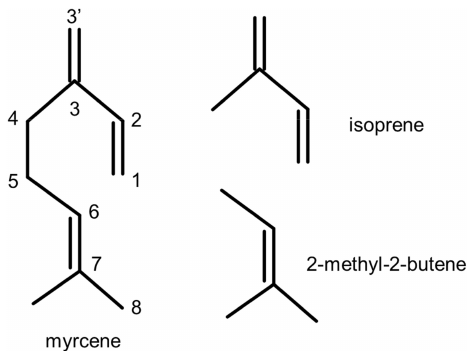
Figure 1. Chemical structures of myrcene, isoprene and 2-methyl-